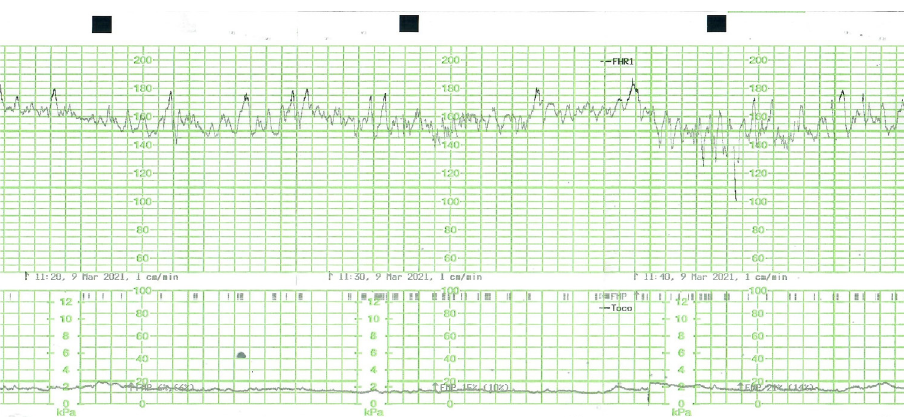
Fig. 1. Cardiotocography at 29+2 weeks of gestation.